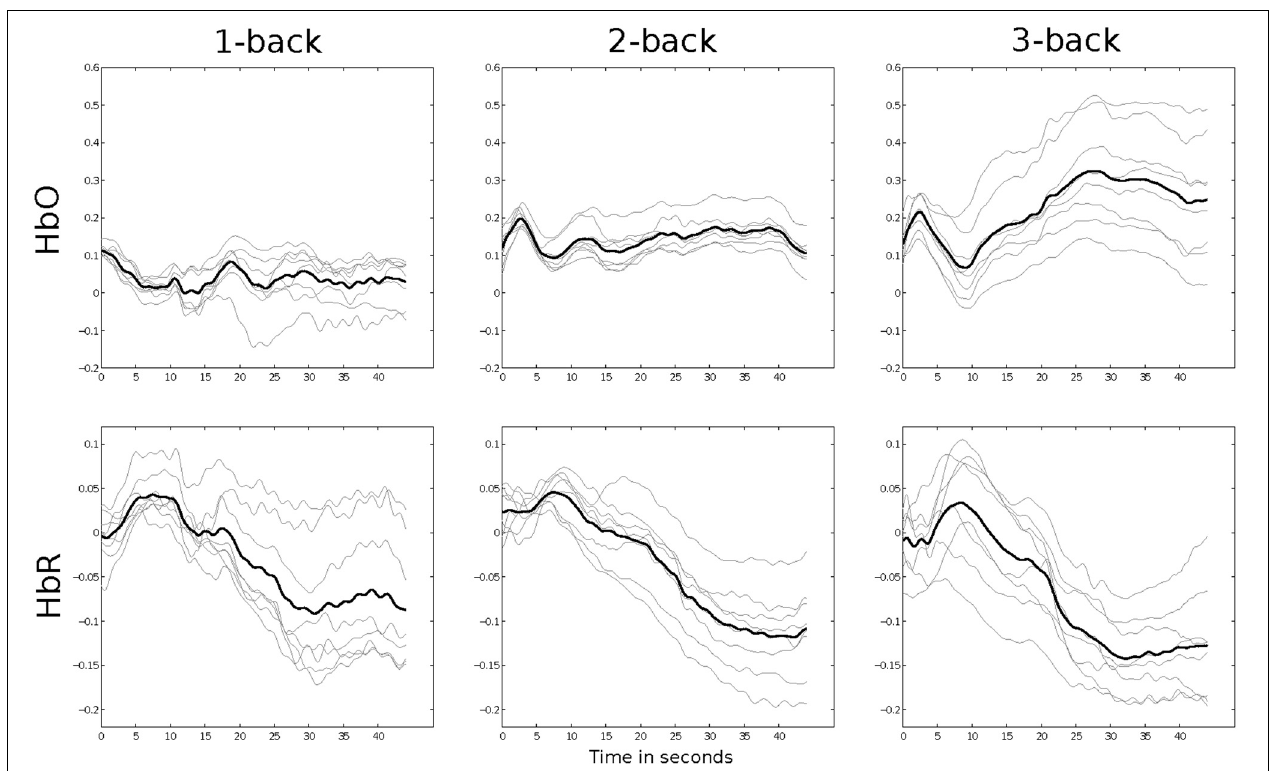
FIGURE 4 | Grand averages of all 10 subjects in the three n -back conditions. Gray lines indicate single channels. The black line presents the mean of all